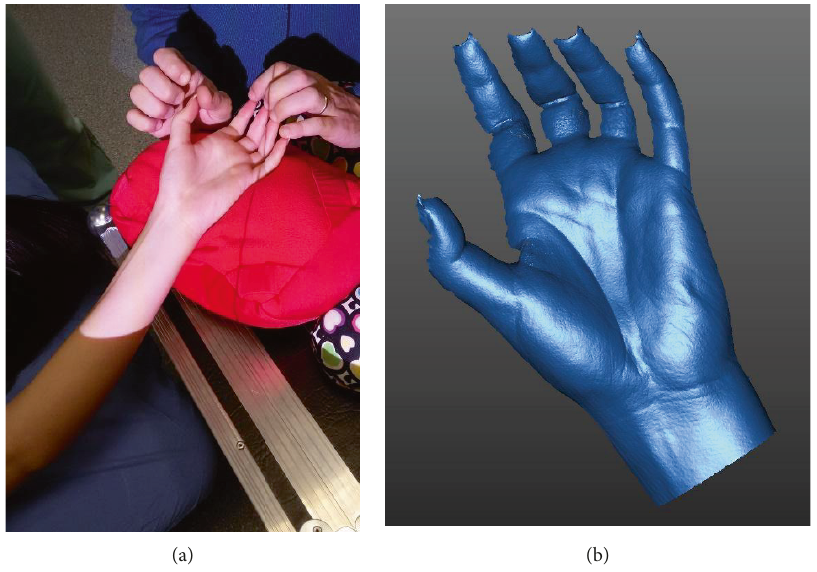
Figure 3: Hypertonic patient: (a) 3D scanning and (b) acquired